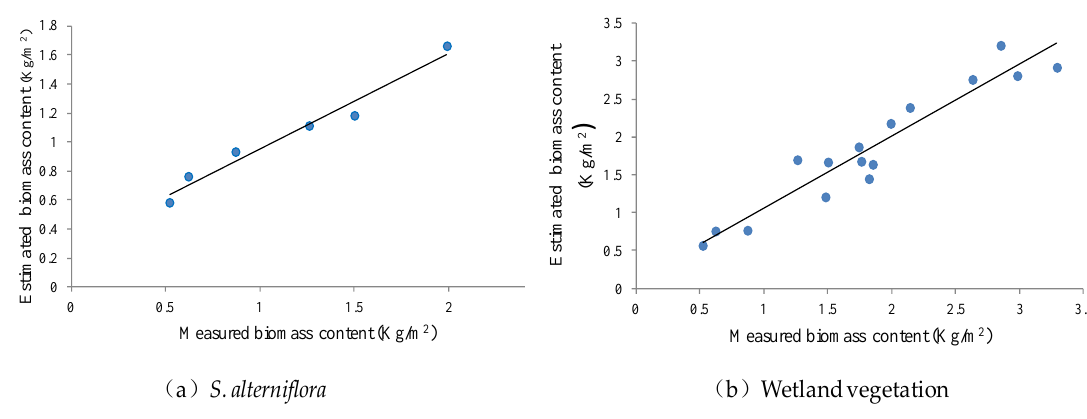
Figure 5. Estimation error of S. alterniflora ( a ) and wetland vegetation ( b ).